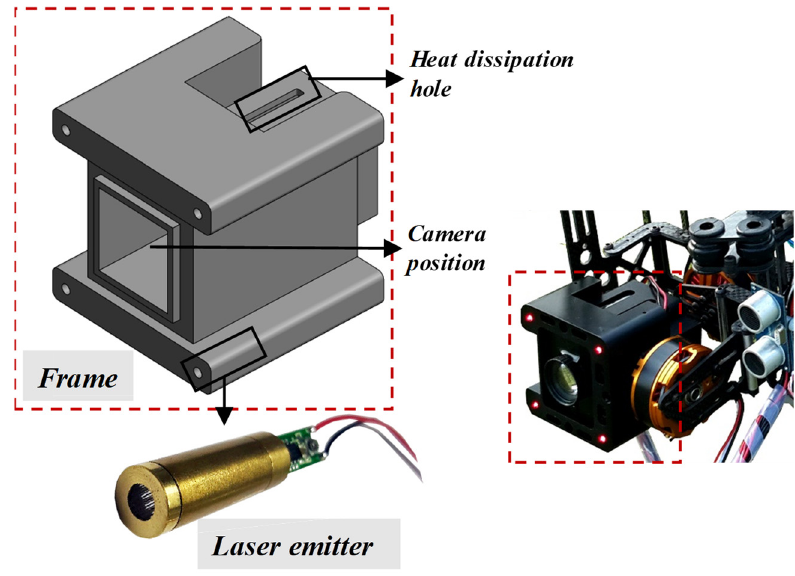
Figure 5. Schematic of the image acquisition module.